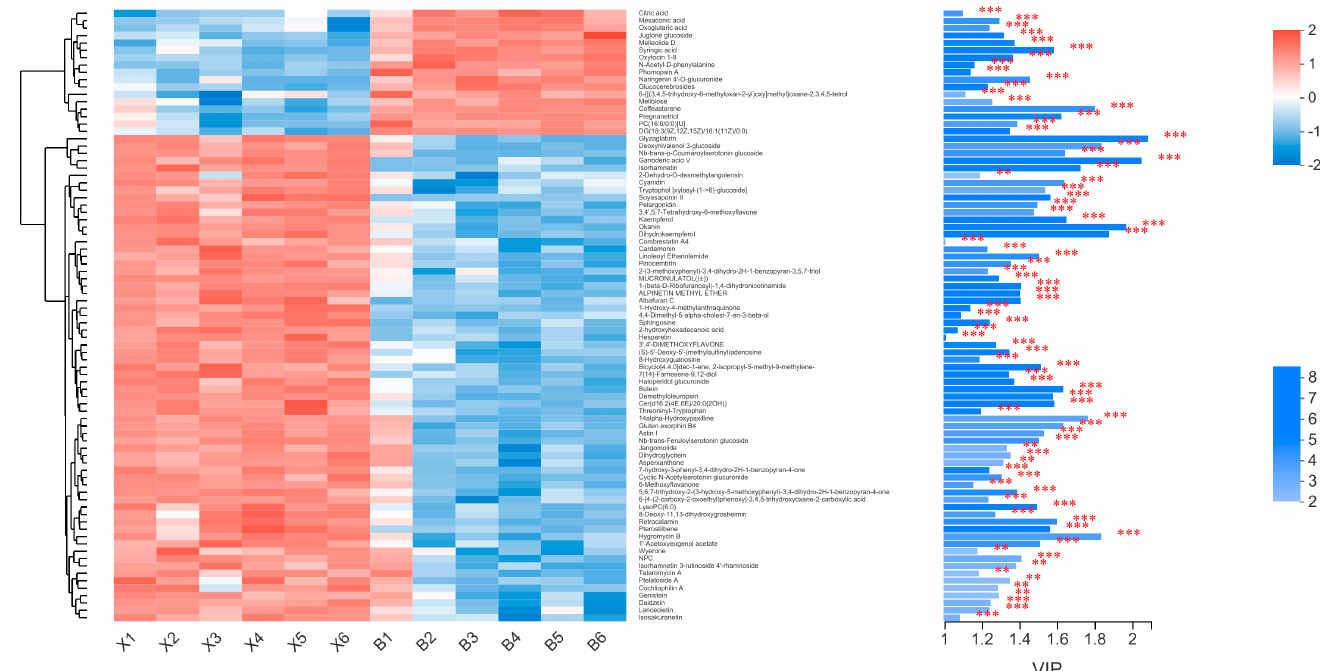
Figure 7. Expression profile and VIP of metabolites. Each column represents one sample, and the sample name is shown below. Each row represents a metabolite, and the color indicates the size of the relative expression of that metabolite in the sample. The correspondence between the color gradient and the numerical size is shown in the gradient color block. The right side is the metabolite VIP bar graph; the bar length indicates the contribution of the metabolite to the difference between the two groups. The default value is not less than 1, and the larger the value, the greater the difference between the two groups. The bar color indicates the significance of the metabolite difference in the two groups of samples, i.e., the p -value, the smaller the p -value, the larger the -log10 ( p -value), and the darker the color. Right side ** represents p < 0.01, and *** represents p < 0.001.